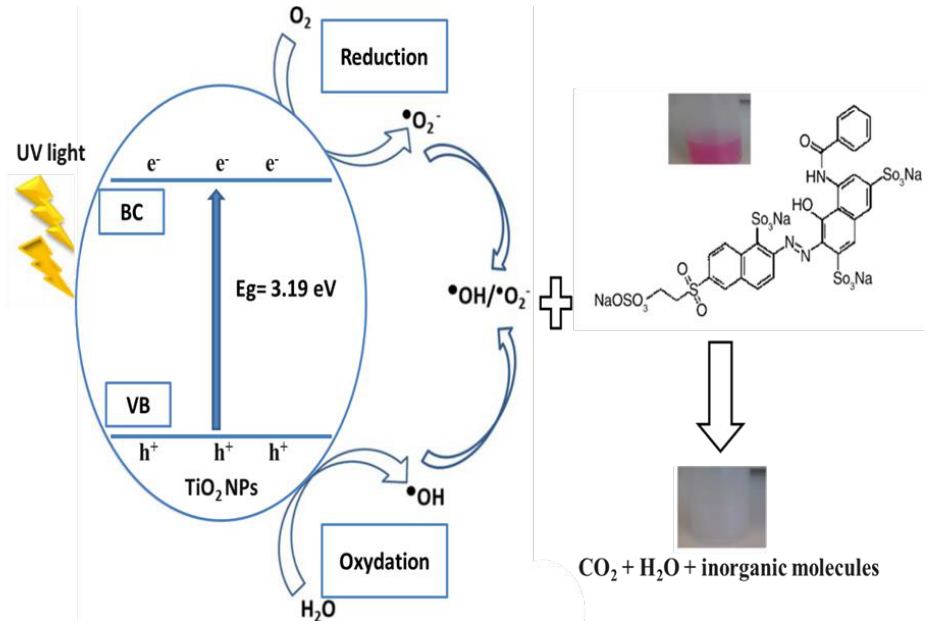
Figure 8. Spectrum of photon energy (αhν) 2 as a function of the hν photon of TiO 2 nanoparticles ( A ) for TiO 2 NPs at 1 h, and ( B ) for TiO 2 NPs at 5 h.